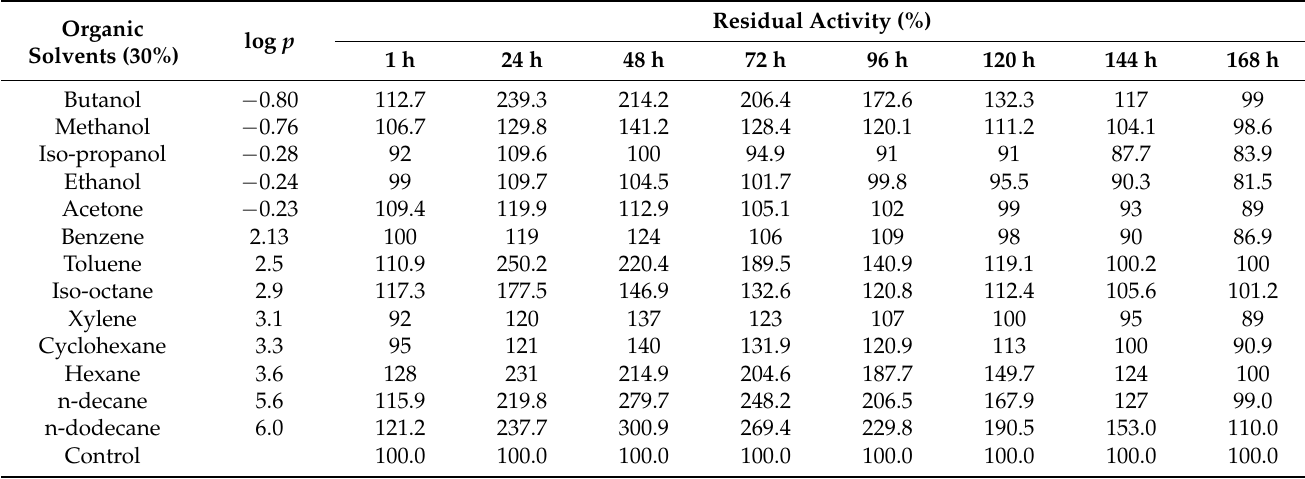
Table 6. Stability of xylanase in presence of various organic